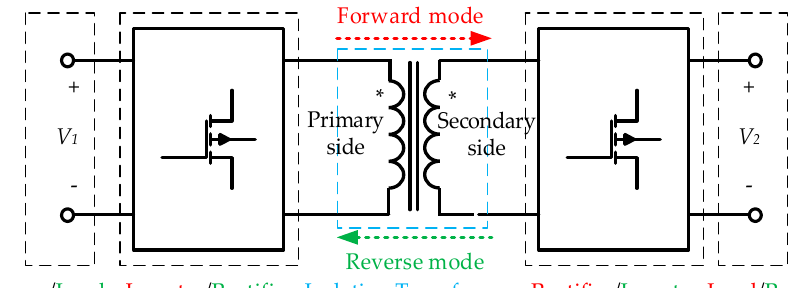
Figure 1. Structure of isolated BDC.